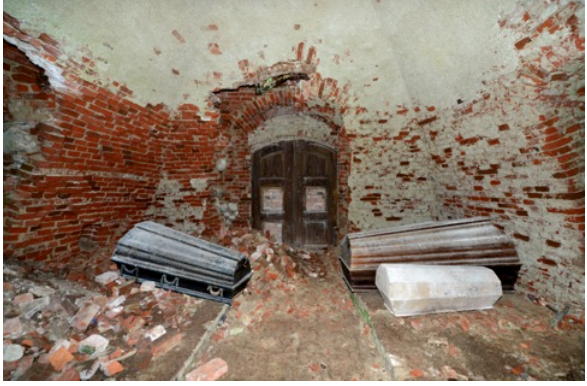
Figure 4. The Pyramid's interior after precursory clean-up. (Photo by H.